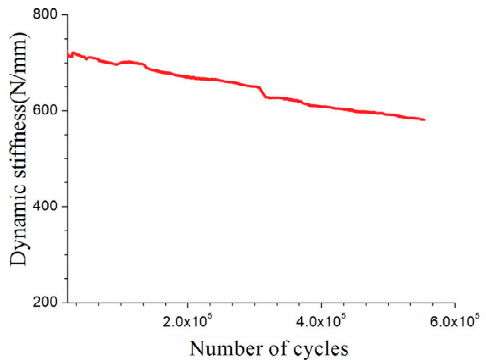
Figure 1. Variation in the dynamic stiffness of the rubber mount with the number of cycles [22].